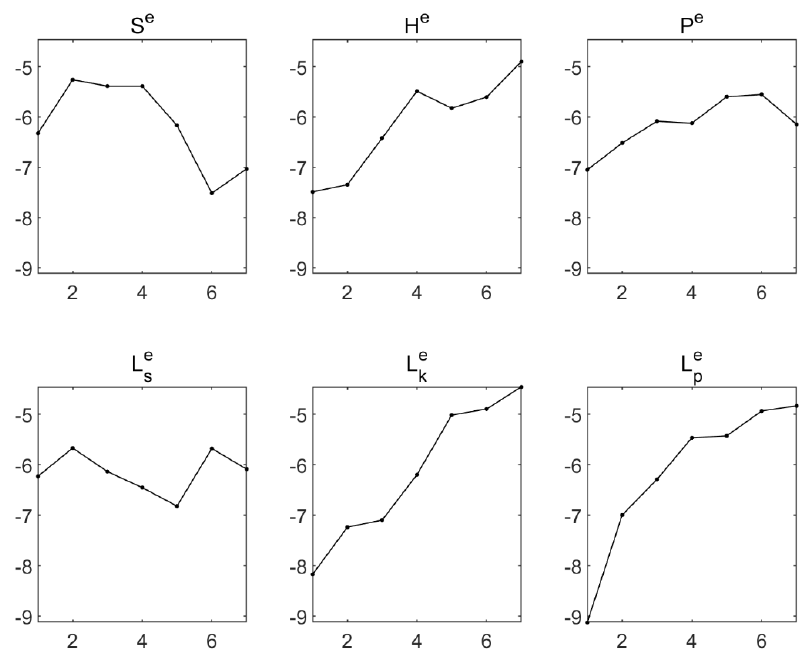
Figure 7. Trend chart of return loss | S 11 | for electromechanical coupling identification parameters of flexible interconnection.